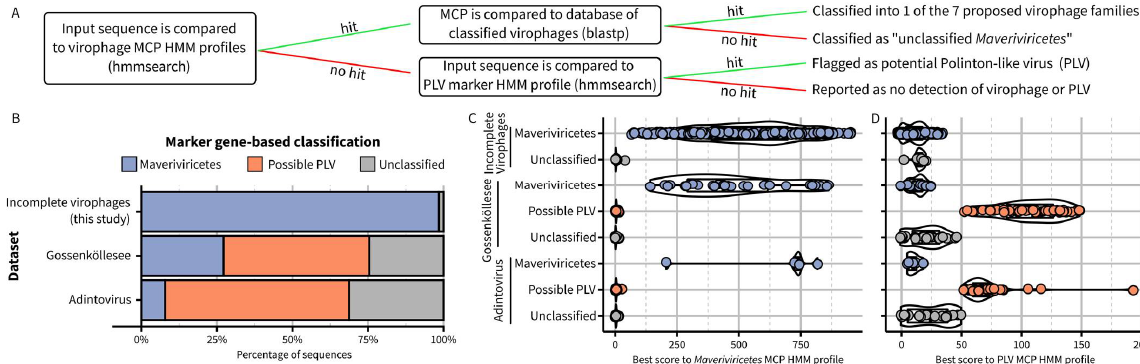
Figure 4. Detection and classification of virophages from published datasets. ( A ) Schematic overview of the hmmsearch- and BLAST-based classification approach used to identify and assign virophages to the proposed families. For panels ( B – D ), three datasets were processed with the approach described in panel ( A ). The first includes non-redundant previously published virophage sequences gathered as part of this study and not included in the complete and near-complete genome set (n = 591; “Incom- plete virophages”). The second includes contigs identified as virophages and Polinton-like viruses assembled from Gossenköllesee metagenomes and published in [19] (n = 114; “Gossenköllesee”). Finally, the third dataset included adintoviruses published in several previous studies [23,32,33] (n = 64; “Adintovirus”). In panel ( B ), the percentage of sequences assigned as Maveriviricetes (based on MCP HMM) or with a hit to the PLV HMM profile is indicated. The score distribution of score for the hits to the Maveriviricetes HMM or PLV HMM is displayed in panels ( C , D ), respectively, for each dataset and each group of